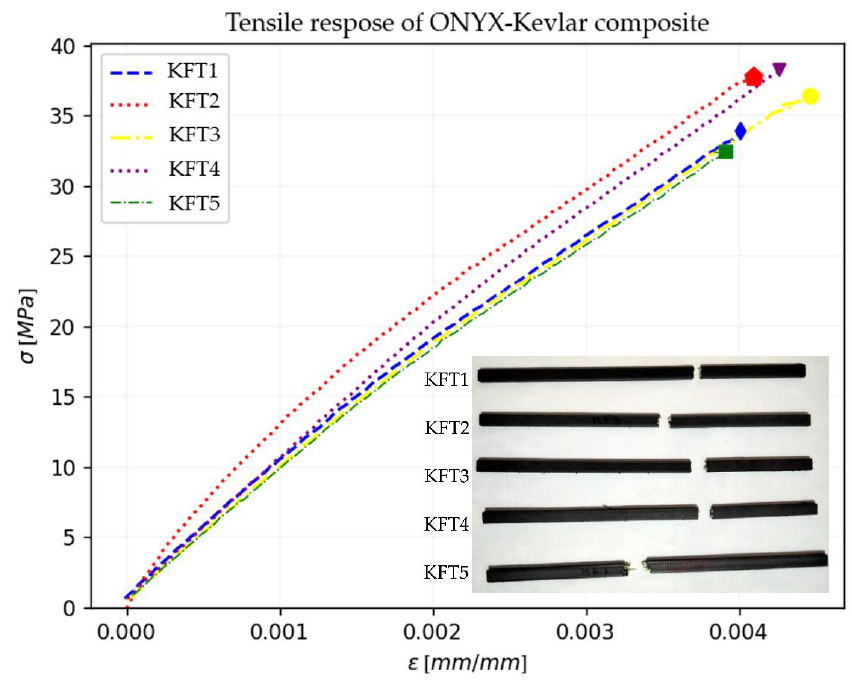
Figure 5. Tensile test stress–strain curves and samples after failure (KFT1, KFT2, KFT3, KFT4 and KFT5 images showed are the actual samples for tensile tests). Table 3. Tensile test results of Onyx™–Kevlar ® 3D-printed